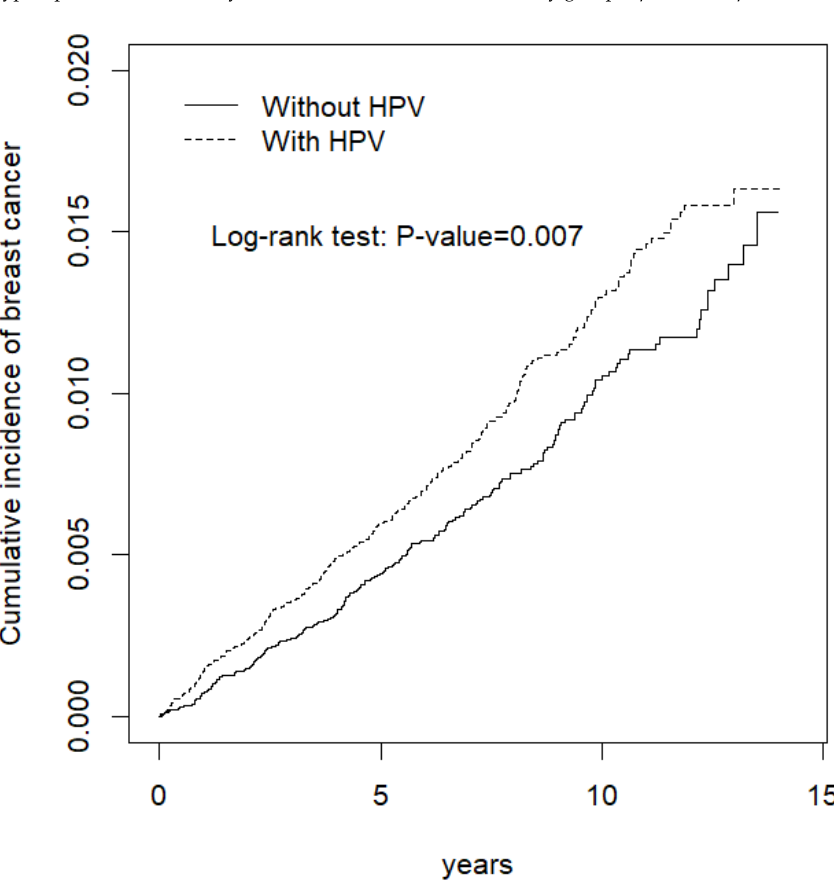
Figure 1. Cumulative incidence of breast cancer in individuals with and without HPV. Table 1. Baseline characteristics of individuals with and without HPV.